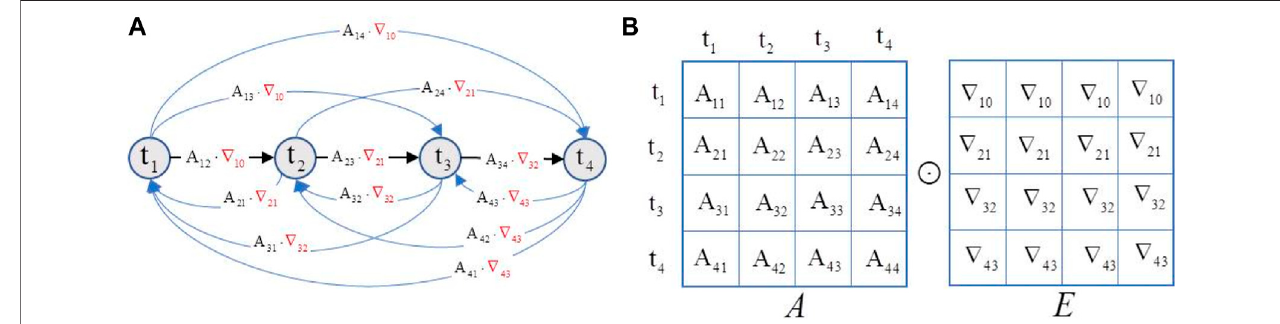
FIGURE 5 | (A) an illustration of constructing graph-structured data from time series PM2.5 data at four different moments, (B) the graph adjacency matrix is computed by using a Hadamard product A ⊙ E between the attention scores A and fi rst-order backward difference matrix E